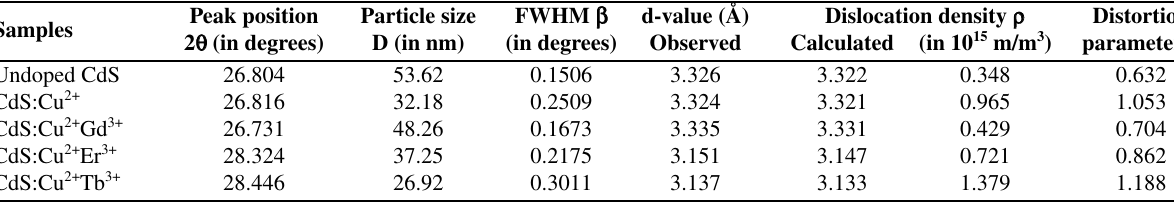
Table 1. Evaluated parameters from XRPD data for undoped and doped CdS nanoparticles Peak position Samples